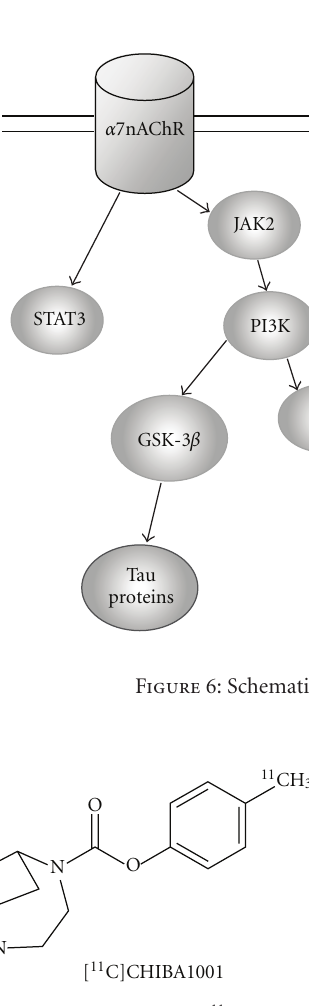
Figure 7: Chemical structure of [ 11